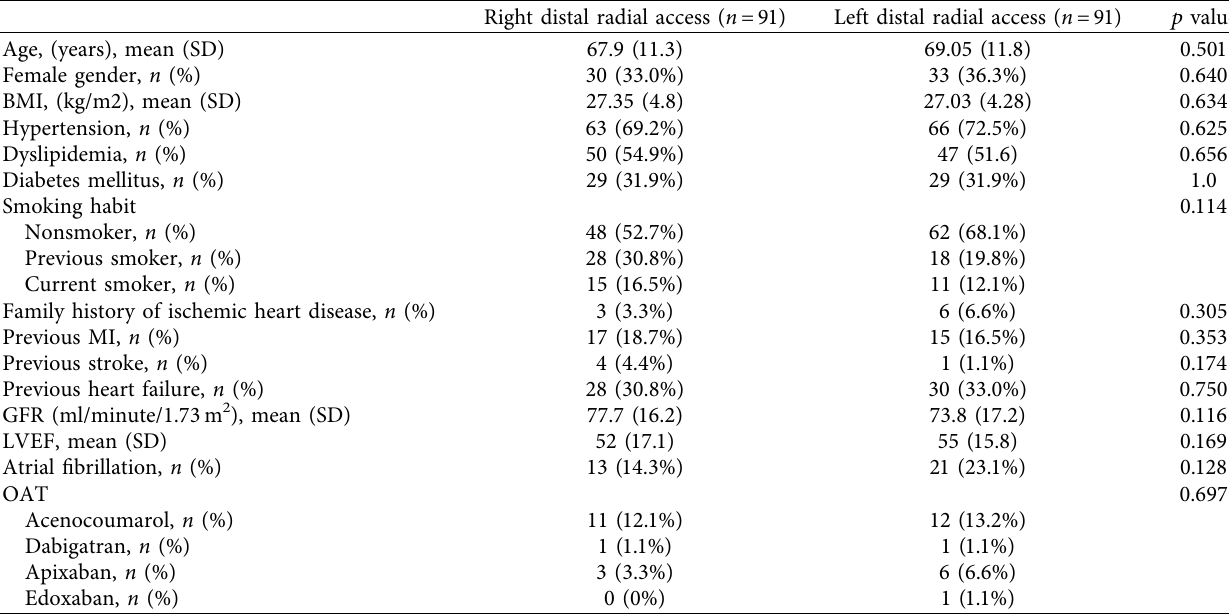
Table 1: Baseline clinical characteristics.